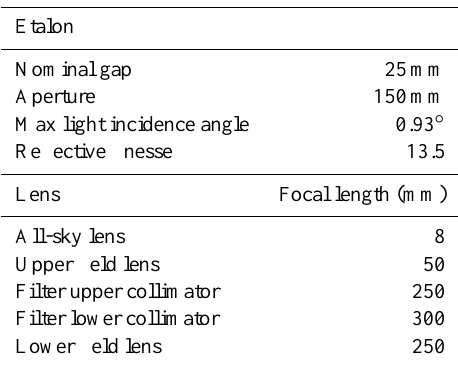
Table 1. Instrument